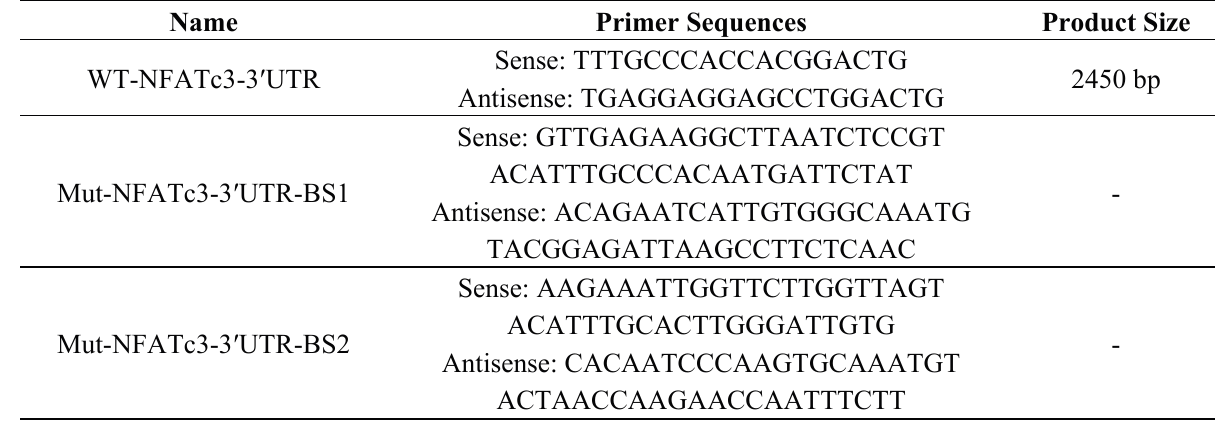
Table 1. The sequences of the PCR primers for constructing NFATc3-3 ʹ